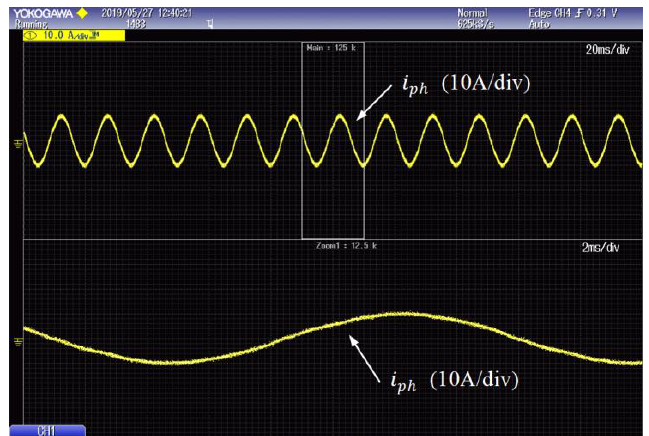
Figure 5. Experimental waveform of the motor current (motor speed = 1000 rpm and motor current =